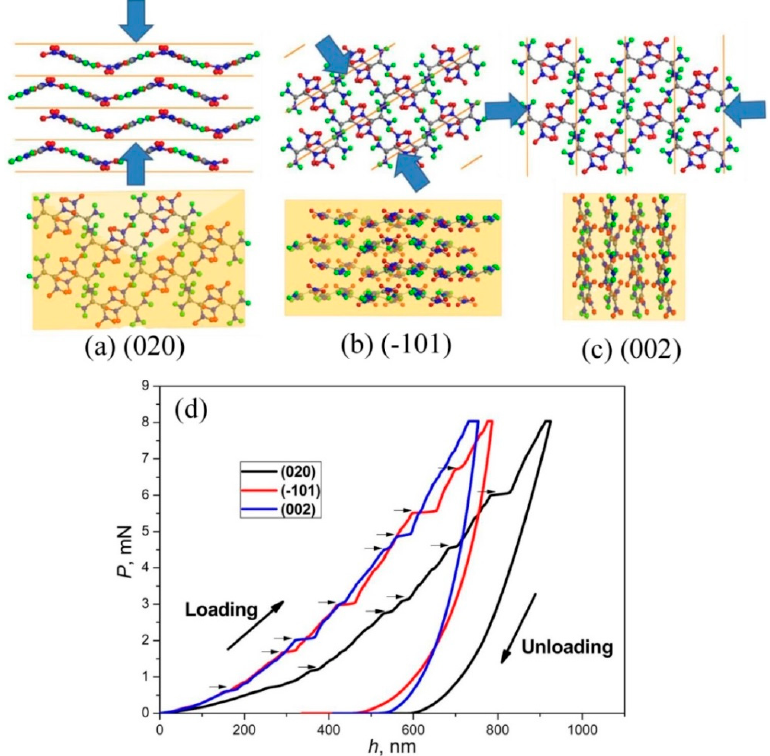
Figure 7. Molecular packing of FOX-7 crystals viewed along (top) and vertical to (bottom) the three indentation orientations of the (020) ( a ), ( − 101) ( b ), and (002) ( c ) faces, and ( d ) P − h curves obtained from (020), (-101), and (002) faces. The horizontal arrows represent pop-ins during loading. (Reproduced with permission from the American Chemical Society, Reference 86).